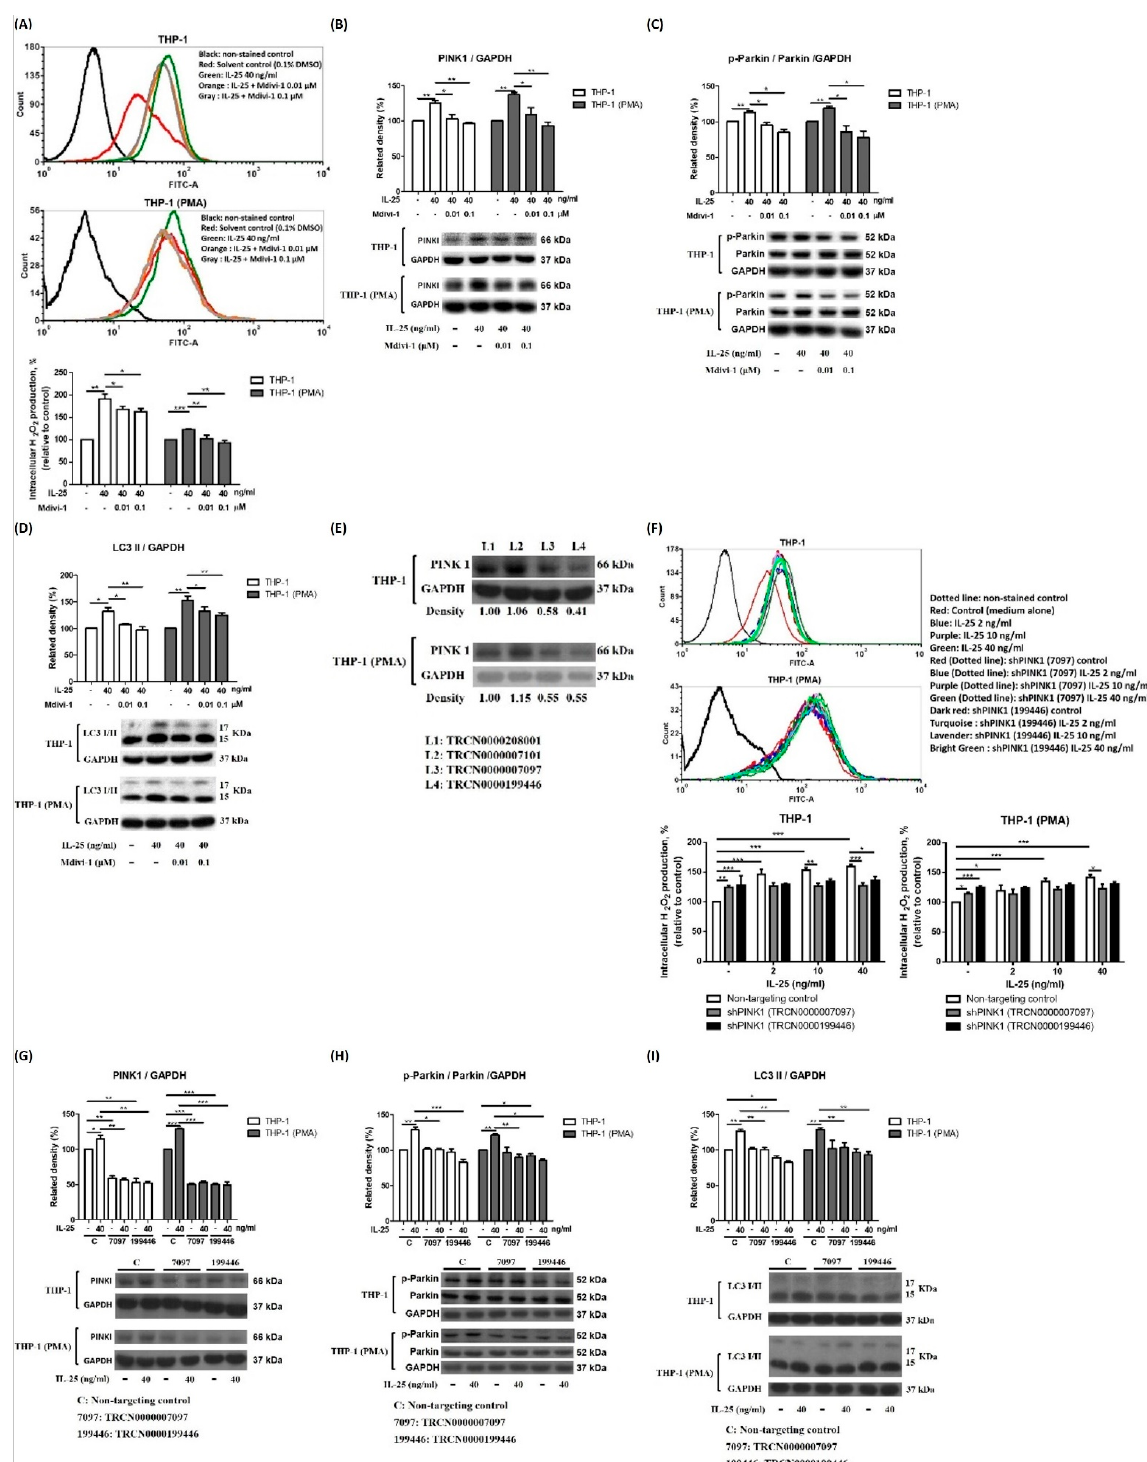
Figure 5. IL-25-induced mitophagy via PINK1-Parkin pathway in THP-1 cells and THP-1 derived macrophages. ( A , F ) representative histograms of cell counts (counts) vs. DCF fluorescence (FITC-A) (above), and the mean fluorescence intensity (MFI) of DCF expressed as a percentage relative to control cells (below). ( A ) After pretreat-ment with solvent control (0.1% DMSO) or mdivi-1 for 0.5 h, the IL-25-induced ROS production in THP-1 cells (white bar) and THP-1 derived macrophages (gray bar) were measured by flow cytometry. n = 3, means ± SD. After pretreatment with solvent